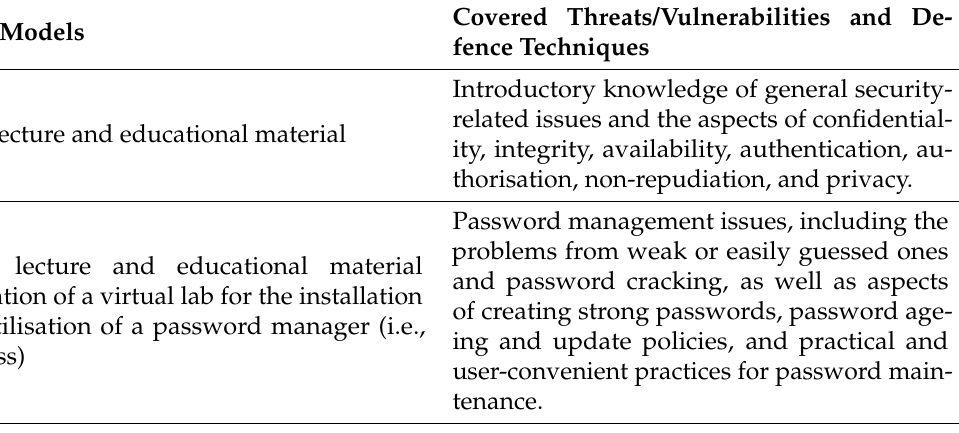
Table 1. Backend security manager training